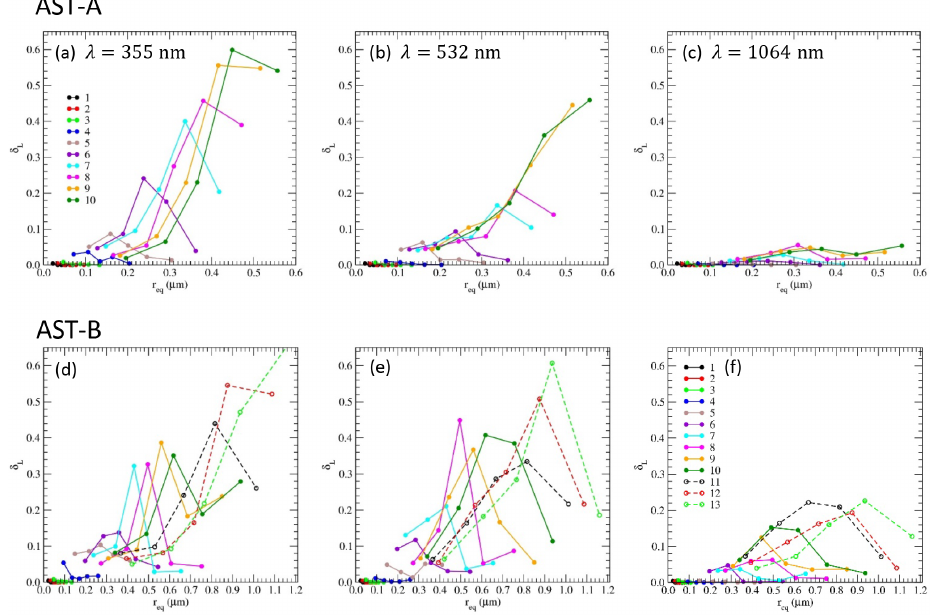
Figure 10. Results of the linear depolarization ratio δ L for particles derived from the AST-A model at wavelengths of (a) 355, (b) 532 and (c) 1064nm. Panels (d) – (f) are the same as (a) – (c) , but for AST-B particle